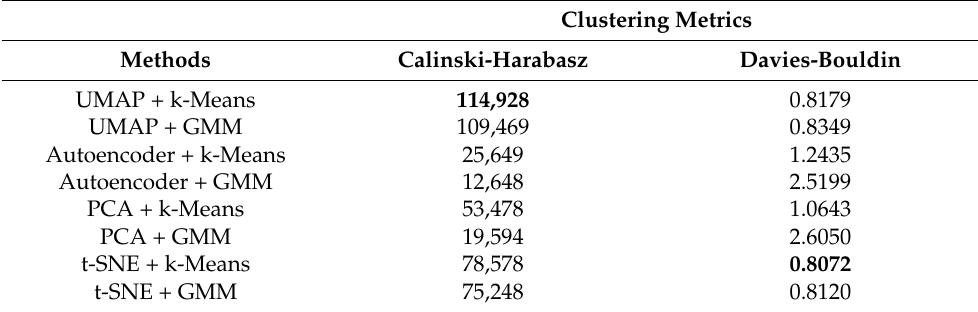
Table 1. Mean of the Calinski-Harabasz and Davies-Bouldin criterion over a range of 5 to 20 clusters for the HRL000040FF dataset, split by method. The best score for each coefficient is in